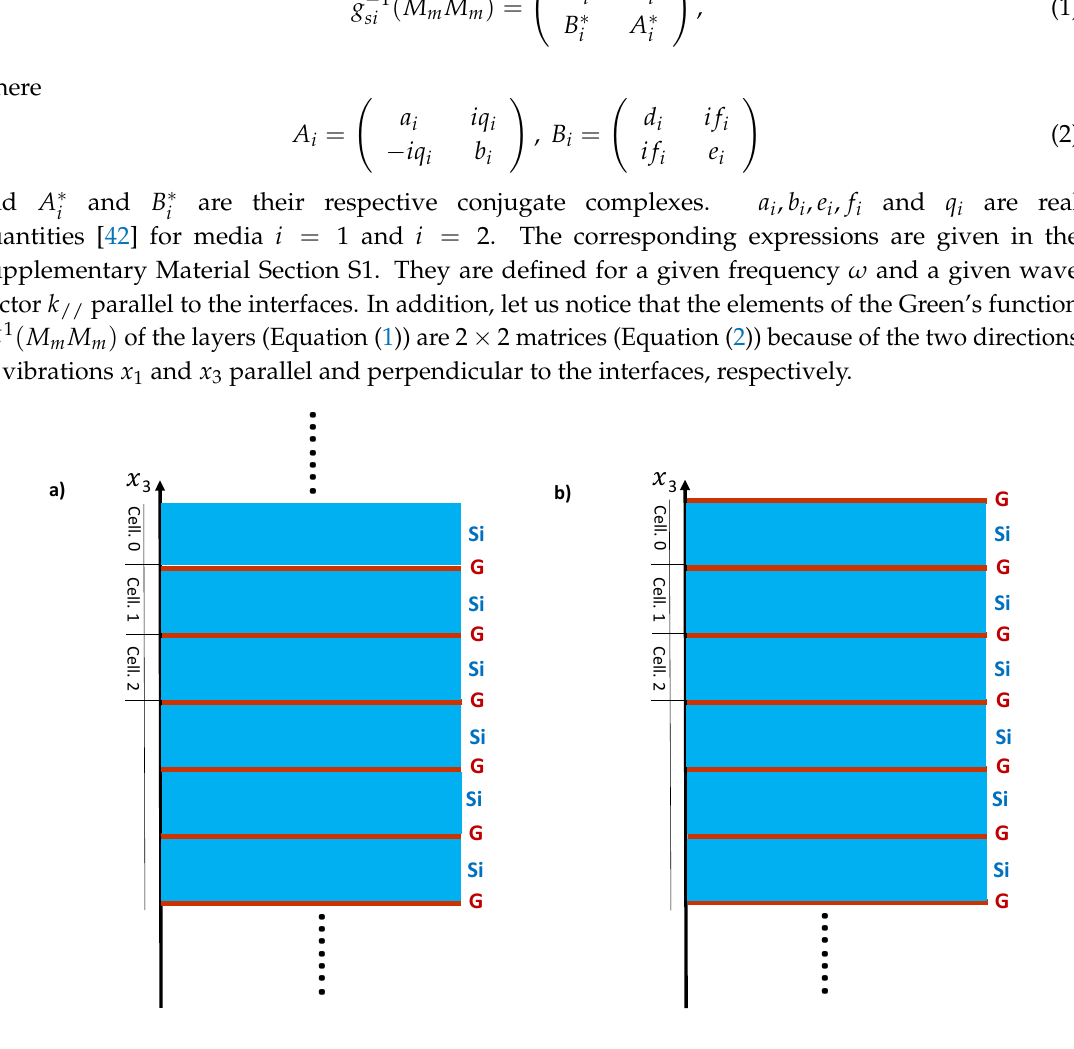
Figure 1. ( a ) Schematic representation of the infinite SL formed of graphene and silicon semiconductor layers denoted G − Si and characterized by the thicknesses d G and d Si . The period of the SL is D = d Si + d G . The x 3 axis of the SL is perpendicular to these layers; ( b ) schematic representation of the semi-infinite SL ended by graphene layer. The surface layer can also be of Si